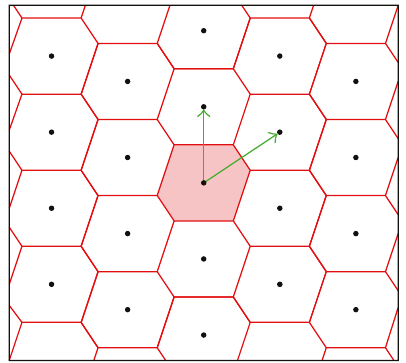
Figure 8: A lattice (black dots) and corresponding Voronoi cells (red). The green vectors compose a possible basis V for this lattice. The Voronoi cell of a given lattice point is the set of points in R N that are closer to this particular lattice point than to any other lattice